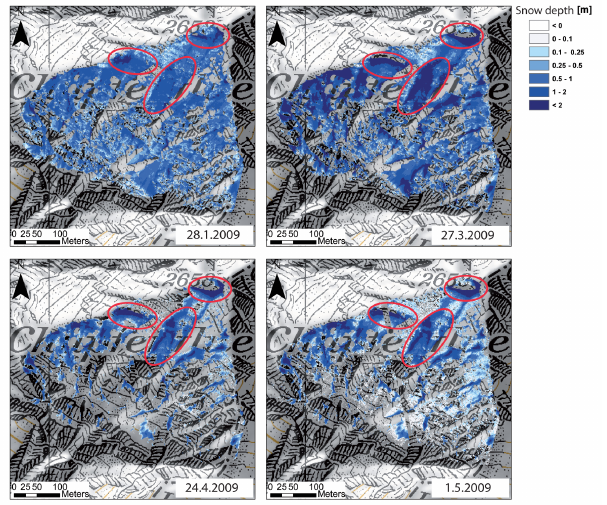
Fig. 5. Snow depth (HS) in the rock face Ch¨upfenflue in winter 2009. The red circles show areas with high HS during the entire winter.